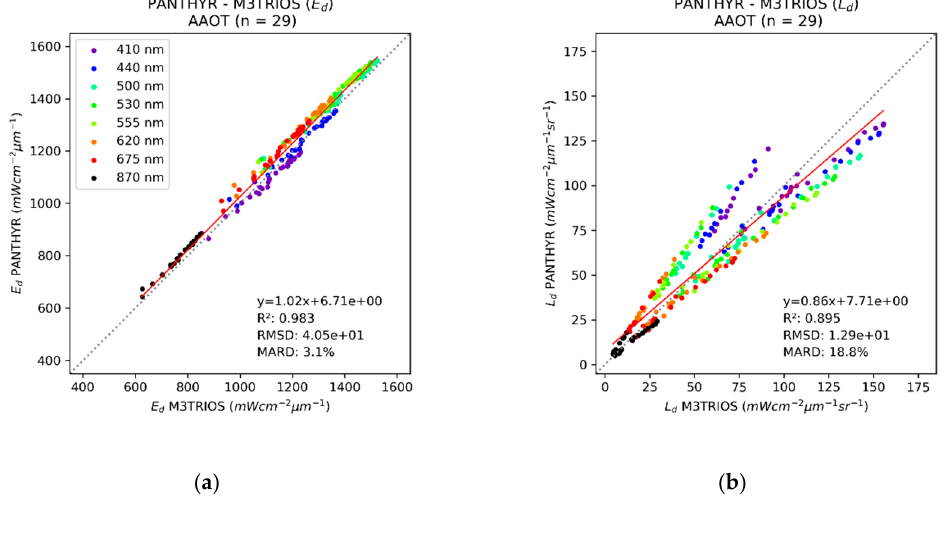
M3TRIOS system (blue dashed lines) and for all 10 measurements from the AERONET-OC system (green dotted line joining dots where the multispectral data exist).